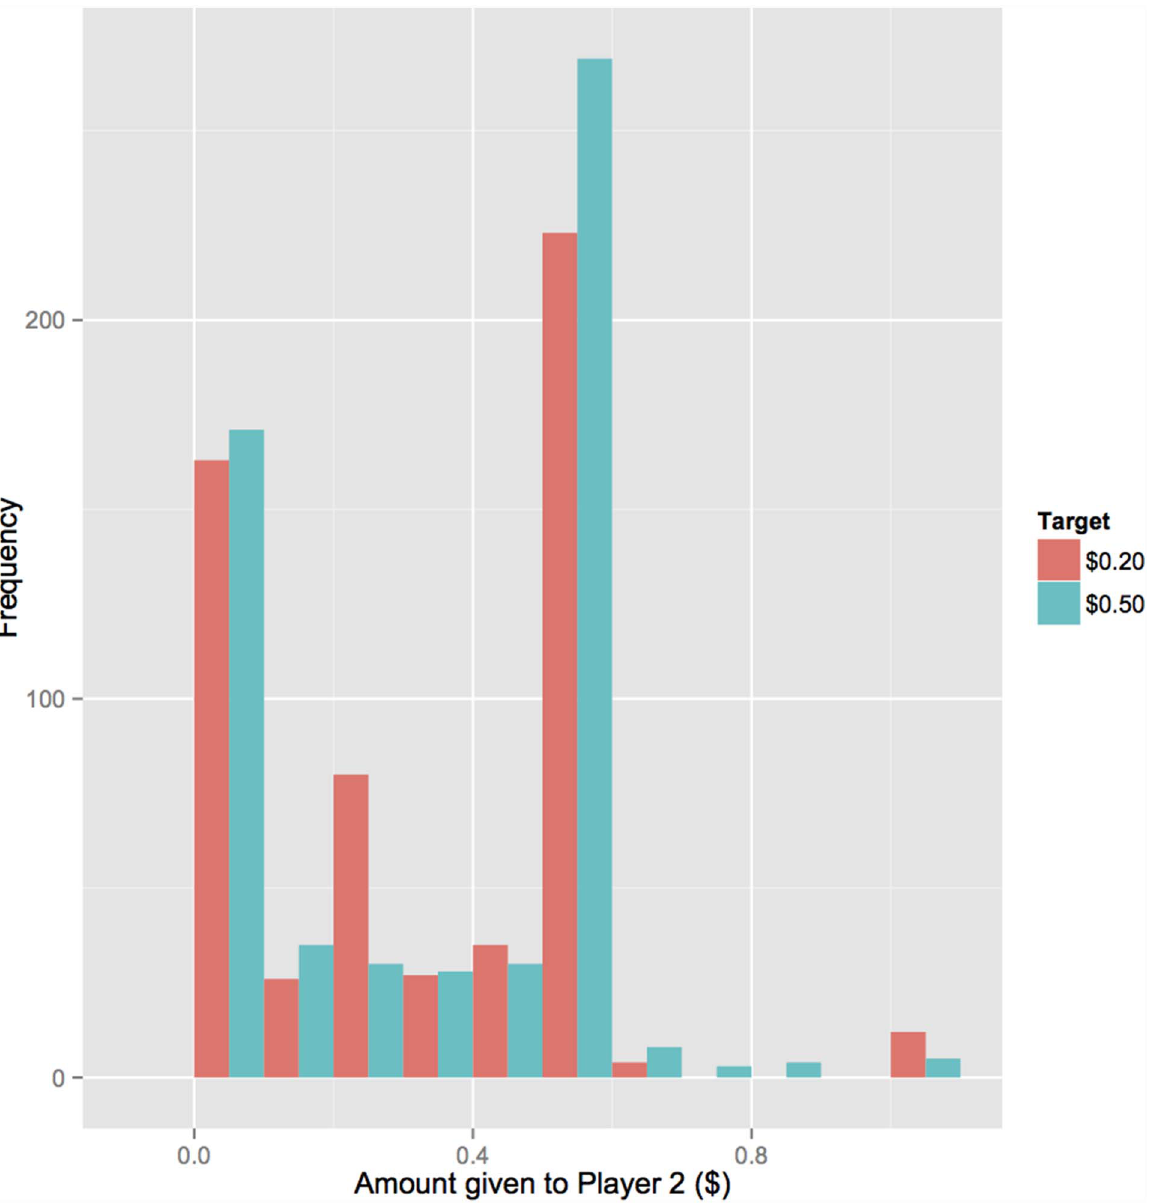
Fig. 1. Histogram of donations Player 1 gave to Player 2 across Experiment 1 and Experiment 2. Data from control treatments are not shown. Red columns are data from players who saw the $0.20 target amount; blue columns are data from players who saw the $0.50 target